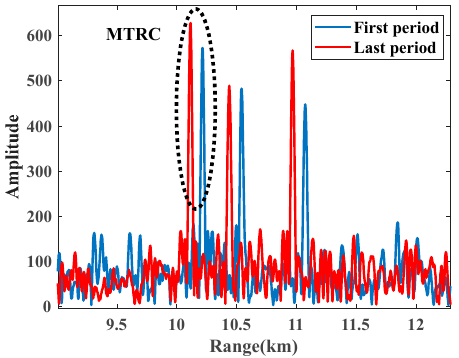
Figure 8. Pulse compression results.